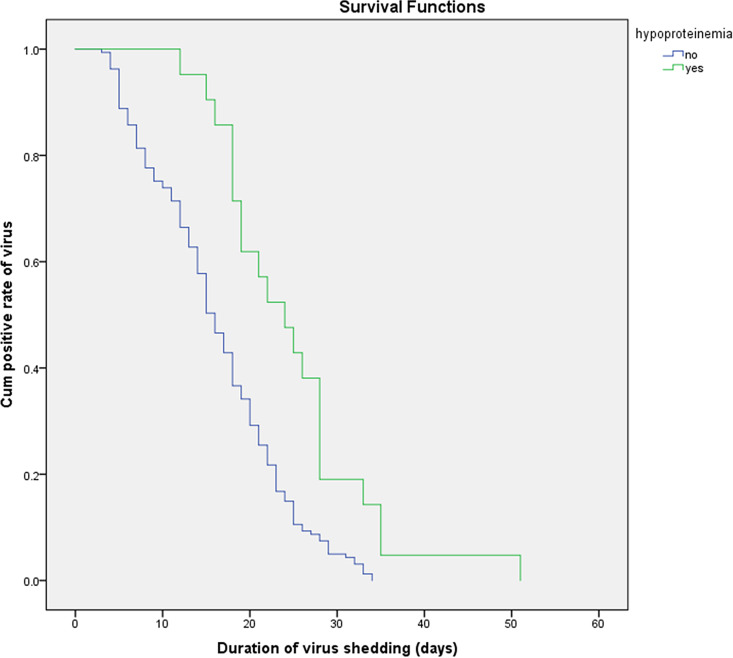
Kaplan–Meier plot for hypoproteinaemia.